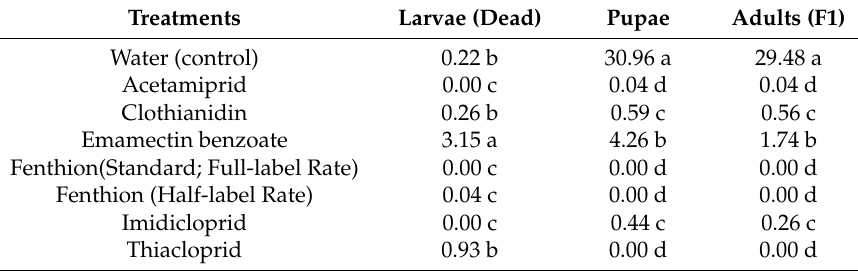
Table 6. Mean Bactrocera tryoni offspring produced from fruit exposed to adults for 48 h, and then sprayed with insecticide (bioassay